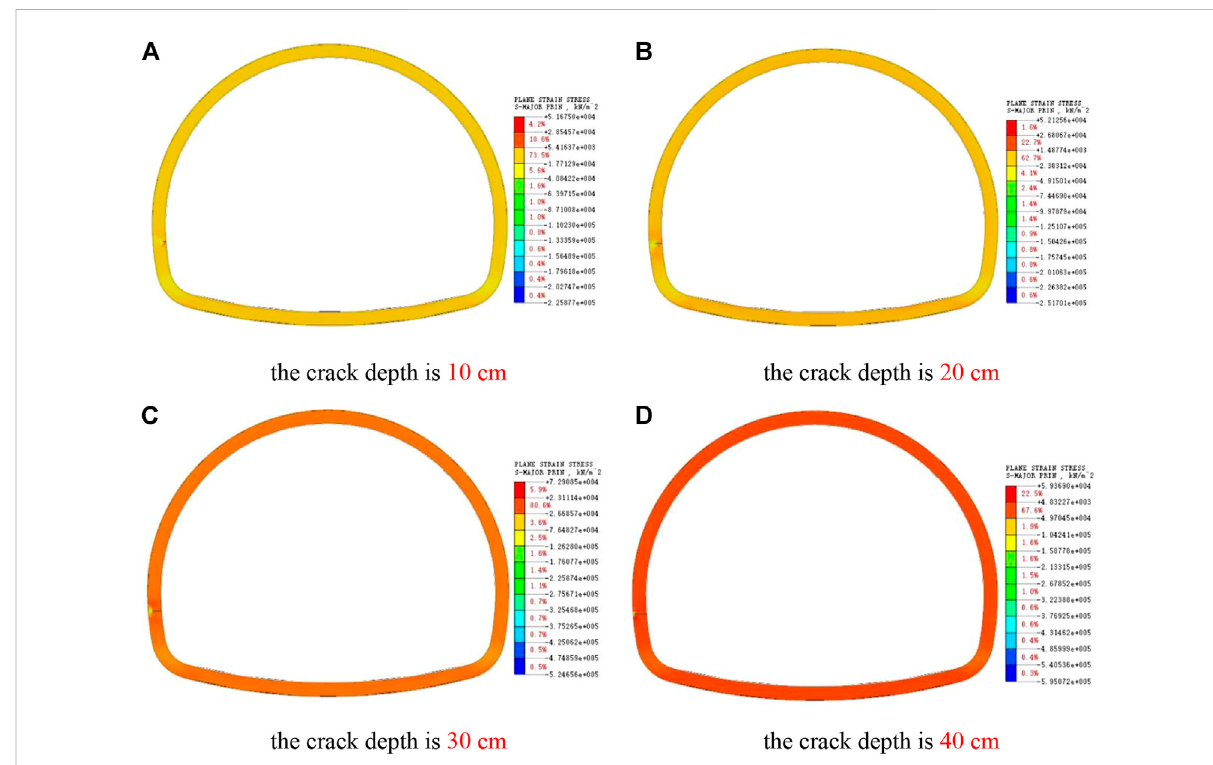
FIGURE 18 Cloudpicturesofmaximumprincipalstressofcracksinsidewallsatdifferentdepths. (A) Thecrackdepthis10 cm. (B) Thecrackdepthis20 cm. (C) The crack depth is 30 cm. (D) The crack depth is 40